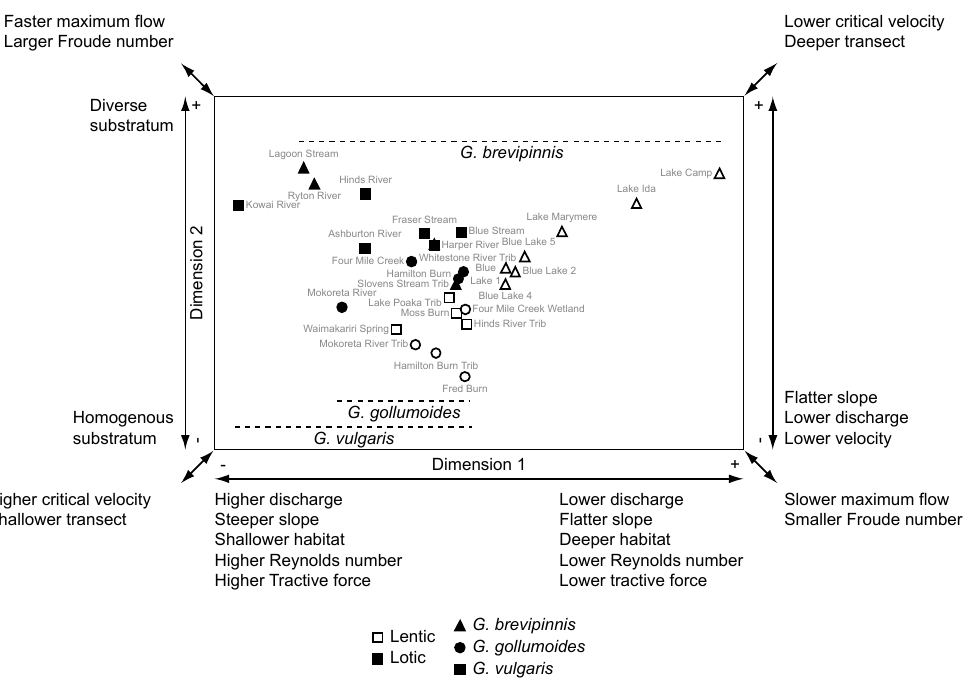
Figure 2. Hydrological environment multidimensional scaling (MDS) ordination of fourteen mean relativised hydrological variables for twenty-nine sampled G. brevipinnis , G. gollumoides and G. vulgaris habitats. Descriptors are interpreted from Spearman ρ correlations of hydrological environment variables and dimension scores significant at p < 0.05 (Table 2). Arrows indicate negative and positive directions across dimensions. Diagonal arrows indicate significant correlations of variables with both dimensions. Spread across dimension 1 for each species is given by dashed lines.